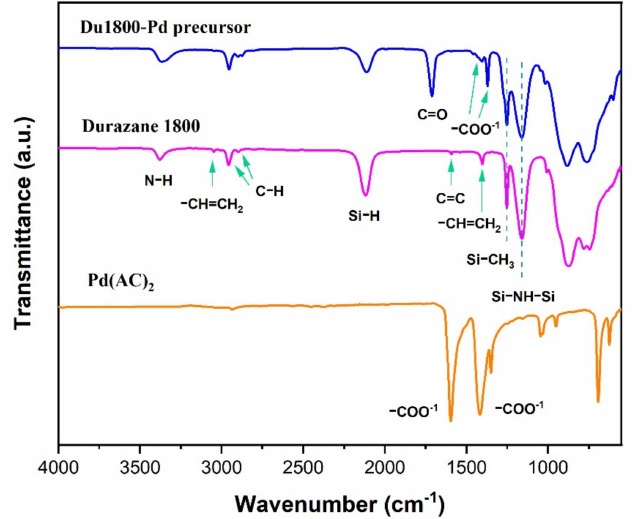
Figure 1. The ATR-FTIR spectra of poly(vinyl)silazane (Durazane 1800) and synthesized Du1800-Pd